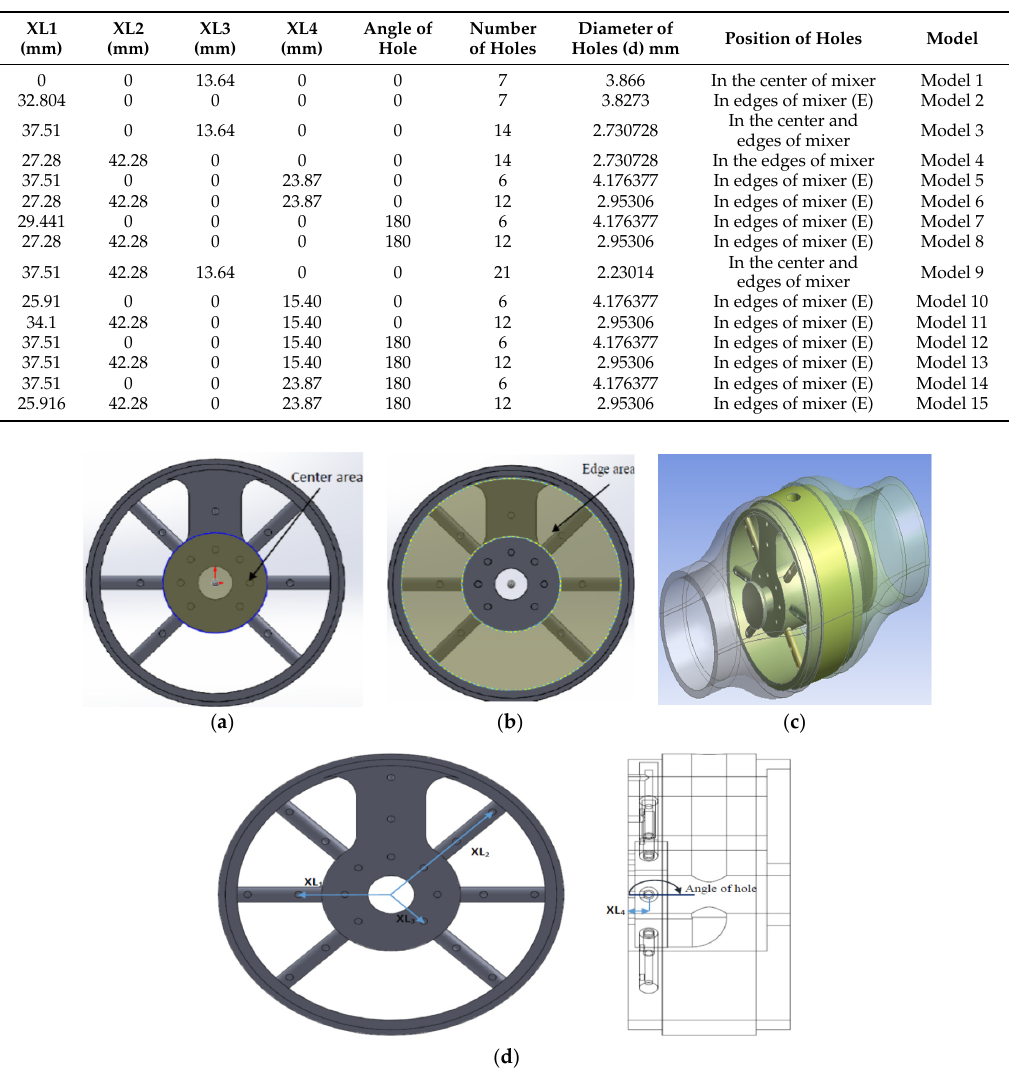
Figure 3. Parameters of main controller body of mixer: ( a ) Central area; ( b ) Edge area; ( c ) Isometric view; ( d ) The distances between the holes and the mixer centers.